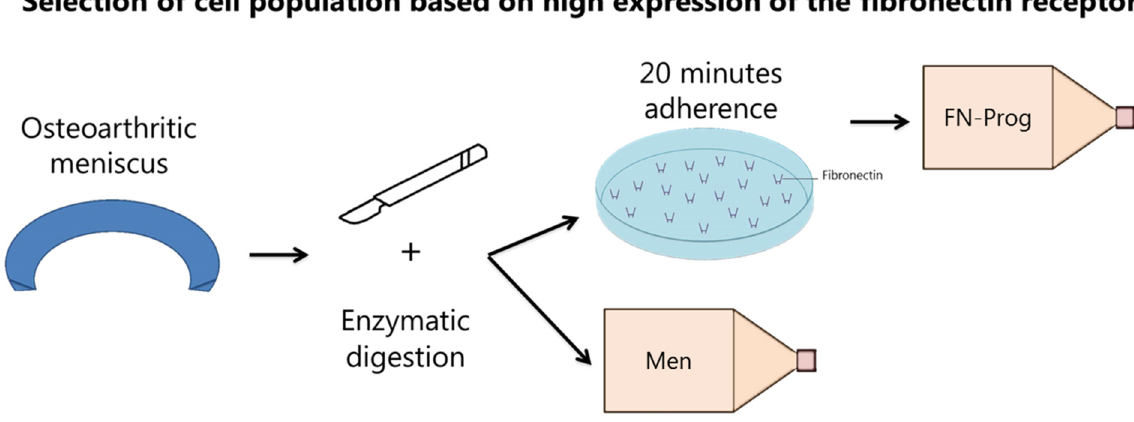
Figure 6. Isolation and selection of cell populations.